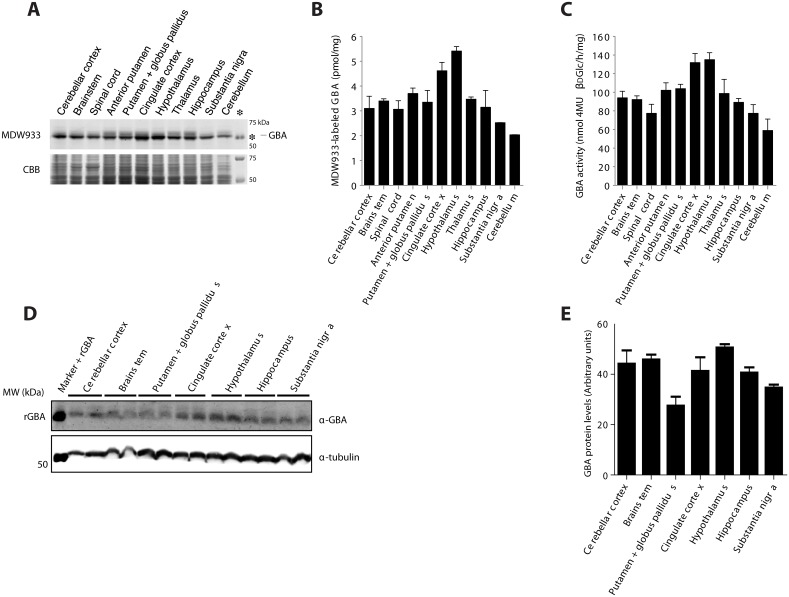
Active GBA in specific brain areas.(A) SDS-PAGE gel of Inhibody MDW933 labeled rat brains areas. The asterisk indicates positive control recombinant GBA signal. As a loading control the same gel was stained with Coomassie brilliant blue (CBB). (B) Quantification of fluorescence expressed per μg of total protein. (C) Enzymatic activity of GBA in brain areas, as determined with 4MU-β-d-glucopyranoside substrate. (D) GBA protein levels in homogenates of rat brain areas assessed by Western blot analysis. (E) Quantification of GBA blot in rat brain areas normalized to tubulin.